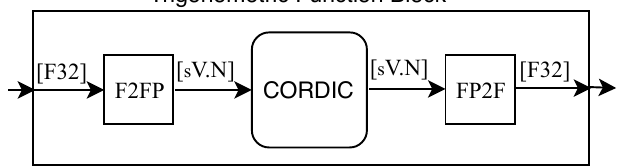
Figure 5. Proposed circuit for calculating trigonometric